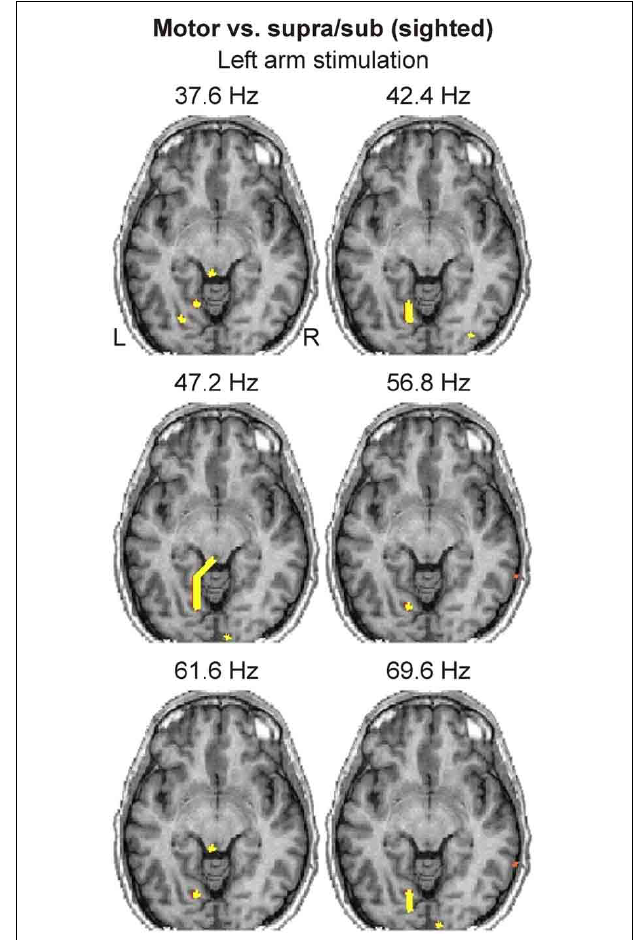
FIGURE 6 | Spatio-frequency activation maps of a sighted subject derived from “Motor vs. Supra/Sub” contrast are shown for left arm stimulation at six frequencies (indicated on top of each image). The axial slice of MRI best covering the visual cortex activations is shown. Yellow contours encompass regions with statistically significant ( P < 0 . 0001) increases in